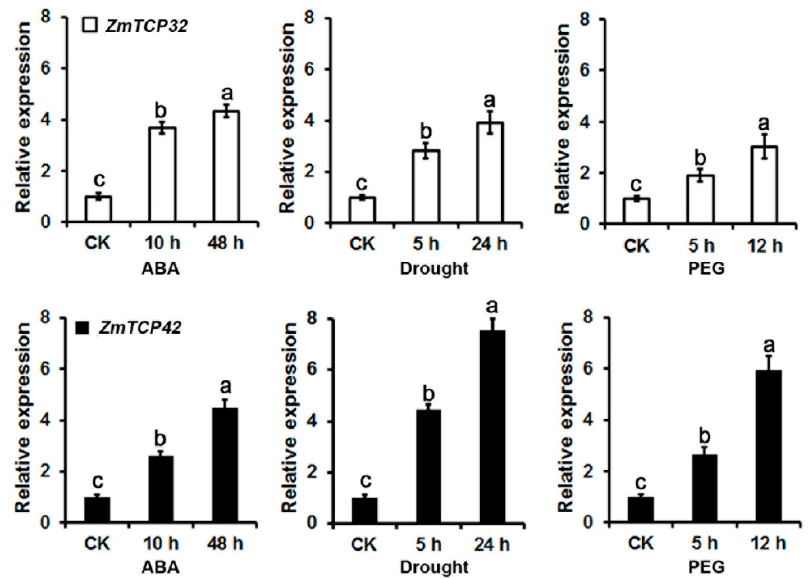
Figure 5. The RNA levels of ZmTCP32 and ZmTCP42 in maize B73 leaves measured by RT-qPCR, after treatment with 100 µ M ABA, drought stress, or 10% PEG treatment. The drought stress was performed as previously described [45], on hydroponically cultured seedlings, for 5 and 24 h, and their relative leaf water contents (RLWC) were determined to be approximately 70% and 58%, at the corresponding time points, respectively. ZmUbi-2 transcript levels were used as an internal control for data normalization; the gene-specific primers are listed in Table S2. Each data point represents the mean ± SD ( n = 3) of three biological replicates. Significant differences were calculated by one-way ANOVA with Duncan’s multiple test (SAS Institute, Inc., Cary, NC, USA). Different letters indicate a significant statistical difference between sample means, at p = 0.05, while means with the same letters were not significantly different.